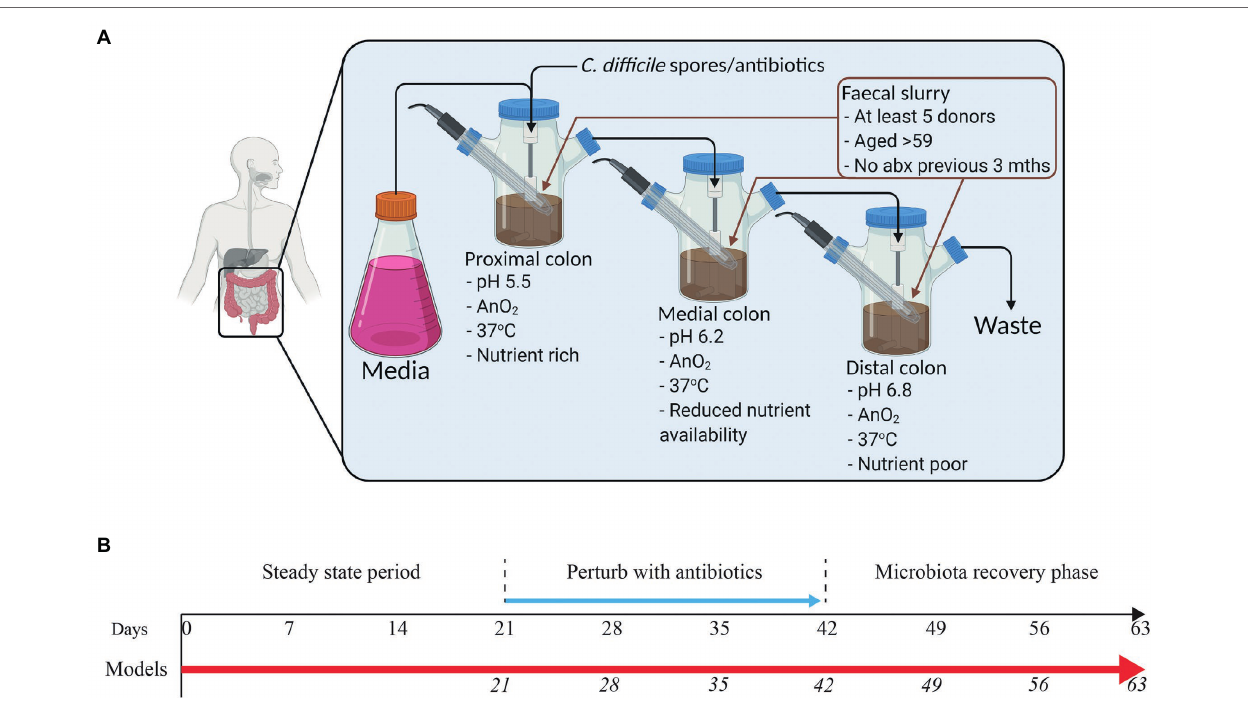
FIGURE 1 | Schematic representation of the human in vitro triple chemostat “gut model” (A) and timeline of the experimental design (B) . Following initialization with a pooled fecal slurry, sarecycline (model S; 17 mg/L once daily), minocycline (model M; 19.3 mg/L twice daily), or doxycycline (model D; 22 mg/L once daily) were administered into vessel 1 for 21 days in each of the three models (blue arrow). Microbial populations were monitored daily throughout the experimental timeline. Days in italics show when samples for DNA extraction were (A) was created using